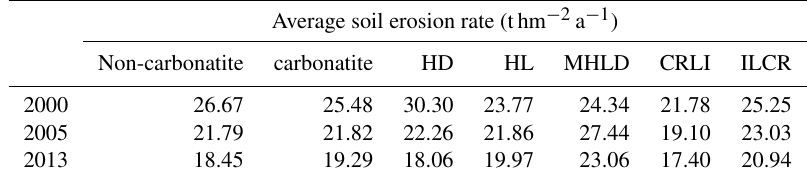
Table 5. Annual erosion rates in different rock outcrop areas.